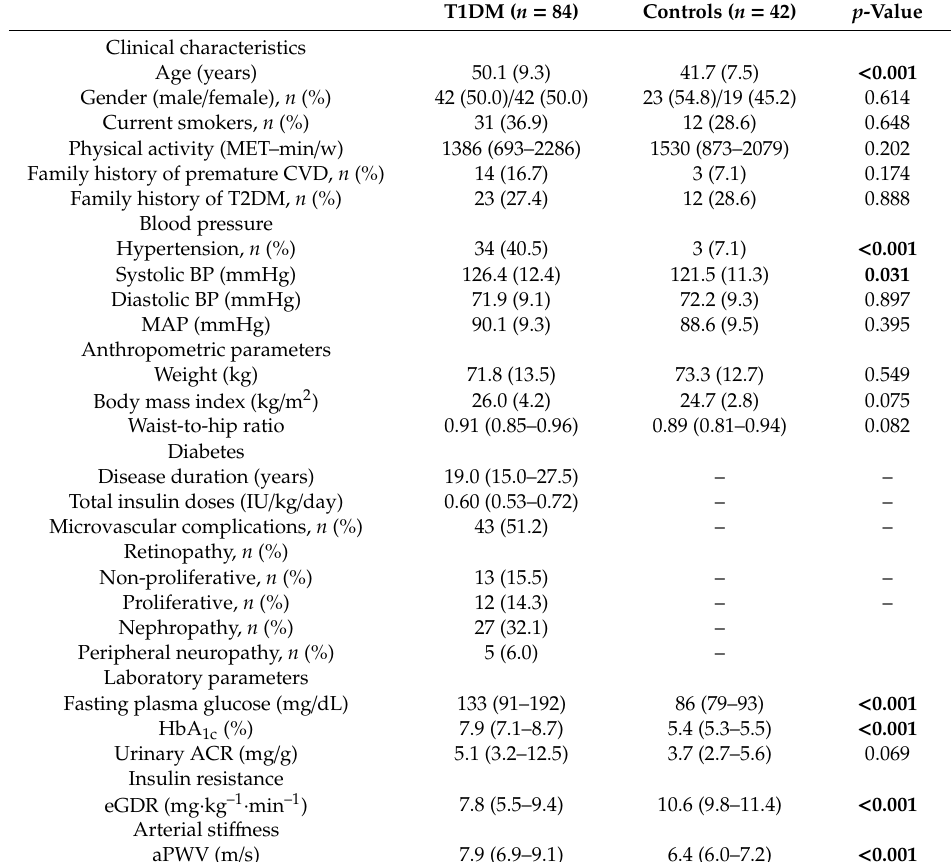
Table 1. Clinical characteristics of the study